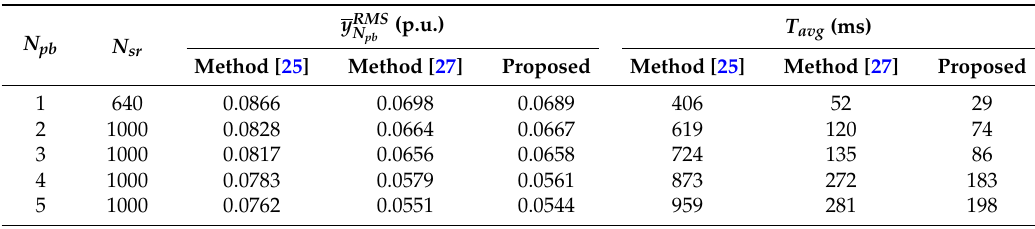
Table 3. Result comparison for IEEE